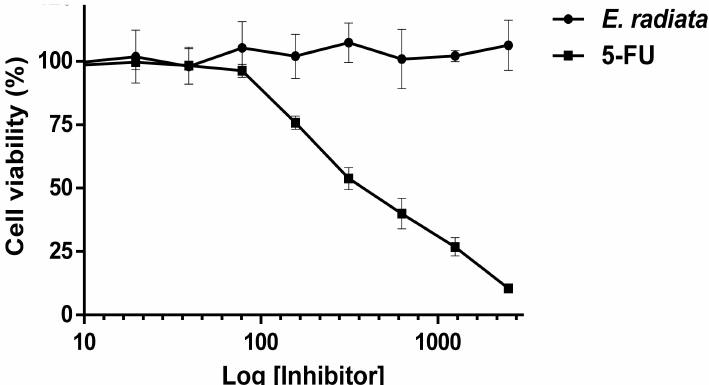
Figure 8. Cytotoxic effects of E. radiata fucoidan and 5-fluorouracil (5-FU) on HCT116 cancer cells. Cell viability was assessed by the resazurin assay. The 5-FU concentration is represented as logarithmic concentrations in µ M and the E. radiata fucoidan as logarithmic concentrations µ g/mL. Points represent means of biological replicates ( n = 3). The error bars shown represent the standard deviations about the mean. Table 3. Synergistic effects of acarbose and fucoidan extracts on α -glucosidase activity. Points